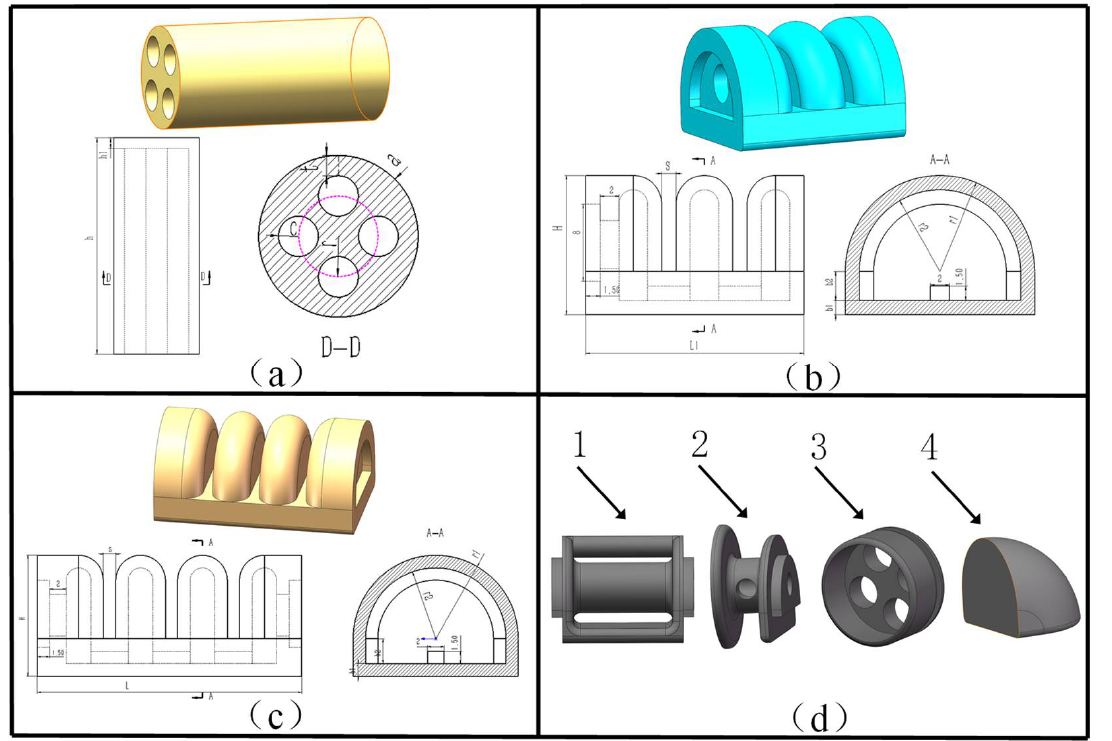
Figure 2. The various parts of the multi-joint soft finger: ( a ) proximal phalanx joint structure; ( b ) middle phalanx joint structure; ( c ) distal phalanx joint structure; ( d ) connecting frame (1—interdigital joint frame, 2—proximal joint frame, 3—face sealing cover, 4—fingertip).